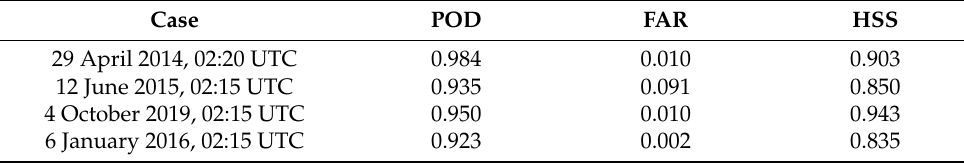
Figure 8. Quantitative comparison of the proposed CM and MODIS CM for the four cases for ( a ) spring (29 April 2014. 02:20 UTC), ( b ) summer (12 June 2015, 02:15 UTC), ( c ) autumn (4 October 2019, 02:15 UTC), and ( d ) winter (6 January 2016, 02:15 UTC). The light cyan colors indicate that both CMs detected the pixel as a cloud. The red pixels indicate that only MODIS CM detected the pixel as a cloud. The green pixels indicate that only the proposed CM detected the pixel as a cloud pixel. The blue colors indicates that both CMs detected the pixel as cloud-free sea surfaces. Tan colors indicate the land mask. Table 3. Statistical comparison between the proposed CM and MODIS